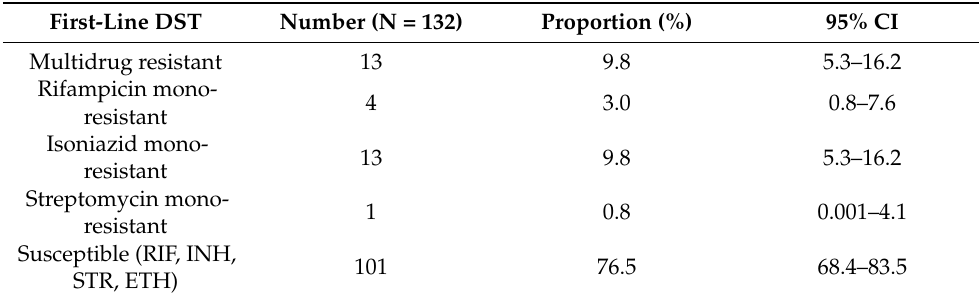
Table 2. Proportions of DR-TB to first-line anti-TB drugs among TB